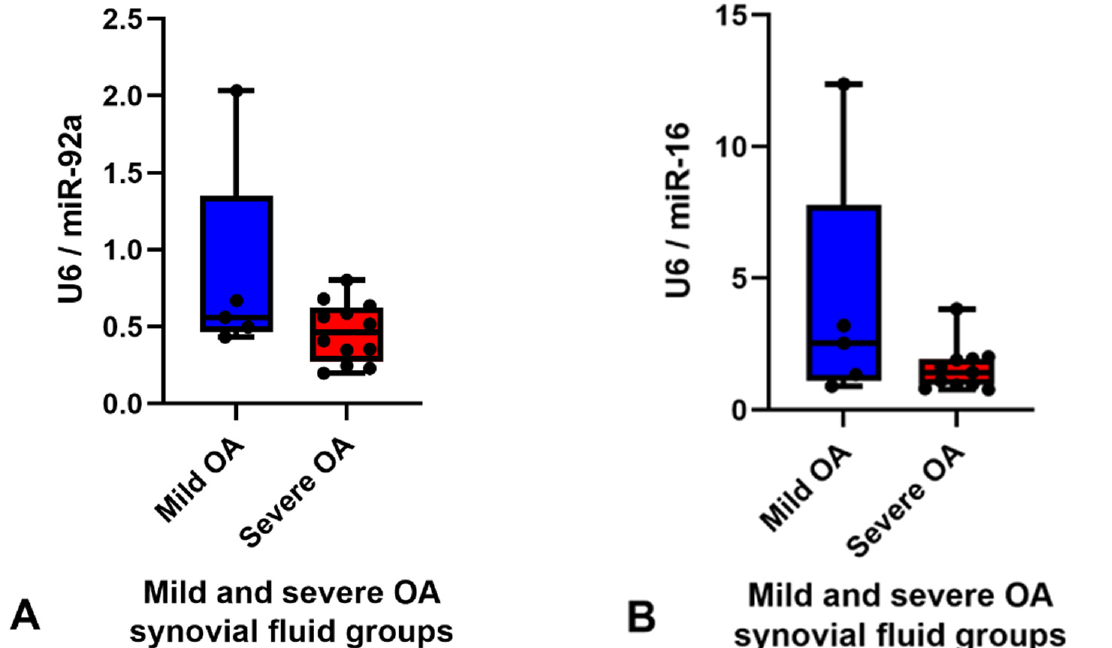
Figure 4. Graphs demonstrating expression levels of miR-92a ( A ) and miR-16 ( B ) in synovial fluid samples in the mild (blue) ( n = 5) and severe (red) ( n = 12) OA groups determined by RT-qPCR. The relative expression was calculated using 2 − ∆∆ Ct using miR-27b as the endogenous control. Boxes show minimum, median with interquartile range and maximum relative expression for each miRNA. Validation did not demonstrate any significant differences between groups, p < 0.05. Osteoarthritis (OA).